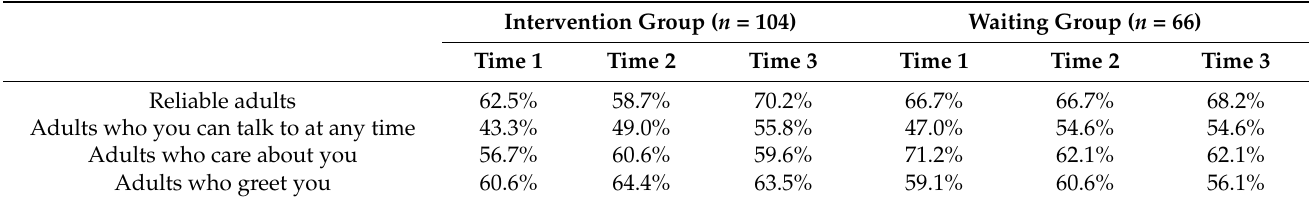
Table 3. Ratio of “the presence of familiar adults” in each group.